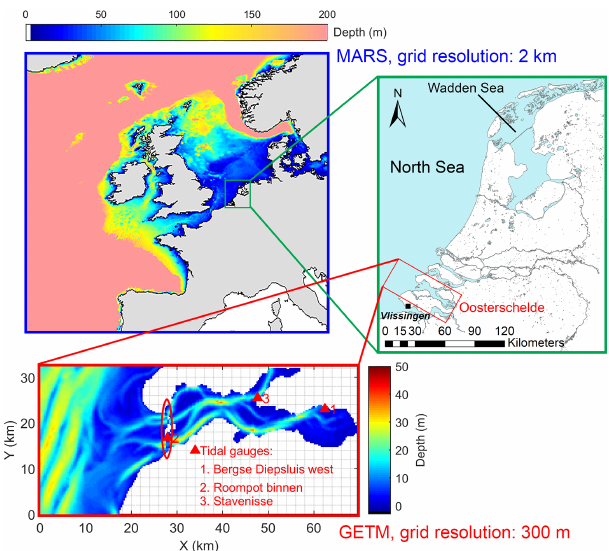
Figure 1. The study area and domains of the two hydrodynamic models representing the European Shelf (blue) and Oosterschelde (red). The green box shows the locations of the Oosterschelde and local SLR projection, Vlissingen, in the zoomed-in map of the Netherlands. In the Oosterschelde domain, tide gauges used for model calibration and the location of the storm surge barrier are marked with triangles and an ellipse, respectively; white areas are land segments protected by dikes where flooding is not